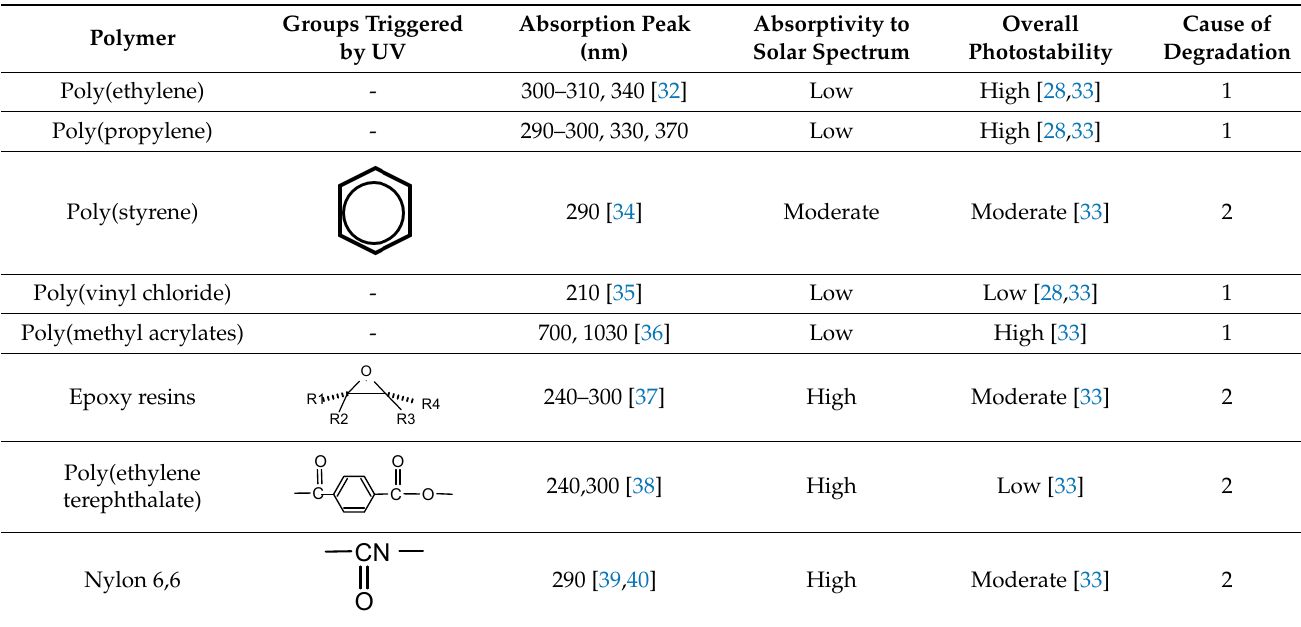
Table 1. Intensity of sunlight absorption in different polymers.